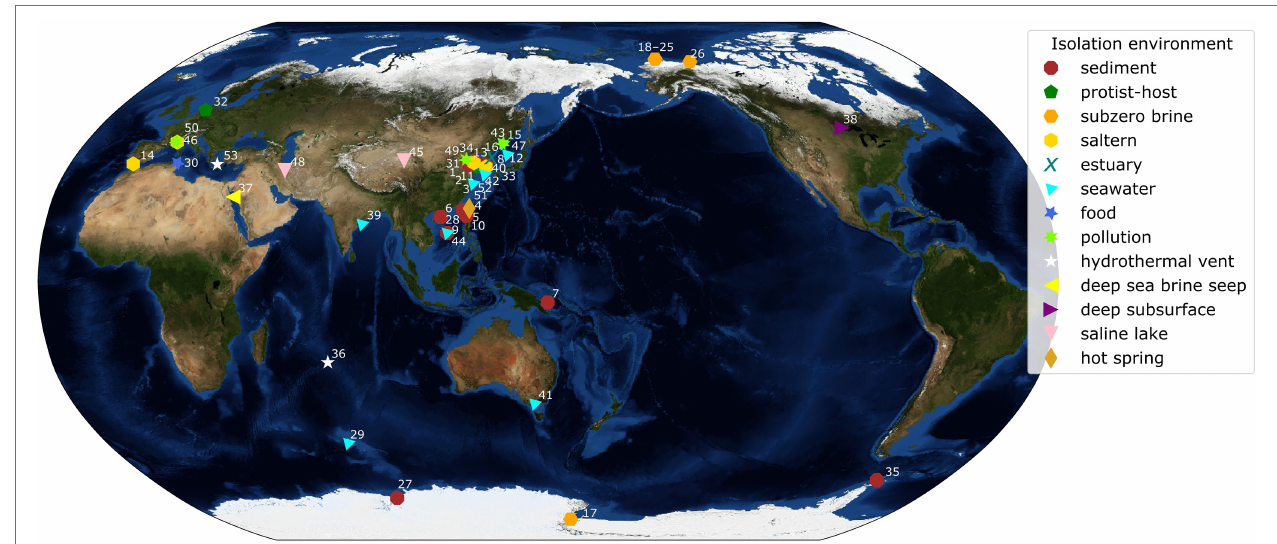
FIGURE 1 | World map with isolation locations of each species of Marinobacter represented in the pangenome. Each symbol and color represents the isolation environment of the species or genome used here. Each point on the map is annotated with an ID number linking that point to its genome description in Supplementary Table 1 . Annotations have been adjusted manually for readability and correspond to a point in the cluster if the area is too crowded. The background image used for the map is the Blue Marble: Next Generation Topography and Bathymetry image created by the NASA Earth